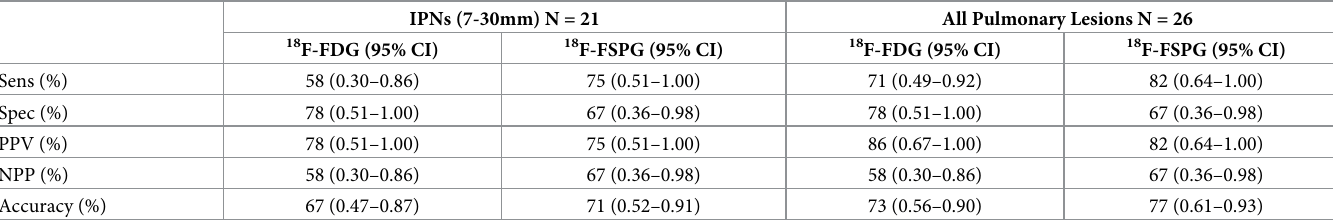
Table 3. Performance Comparison of 18 F-FSPG and 18 F-FDG for IPNs and combined IPNs and lung masses.